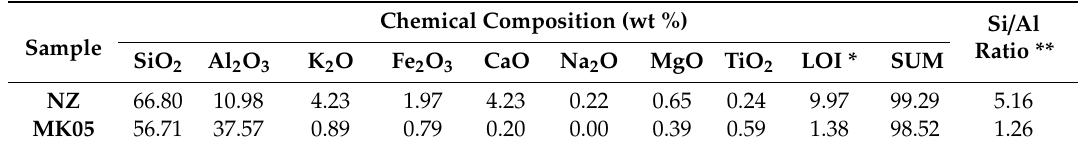
Table 1. Chemical composition of natural zeolite and metakaolin Chemical Composition (wt Sample